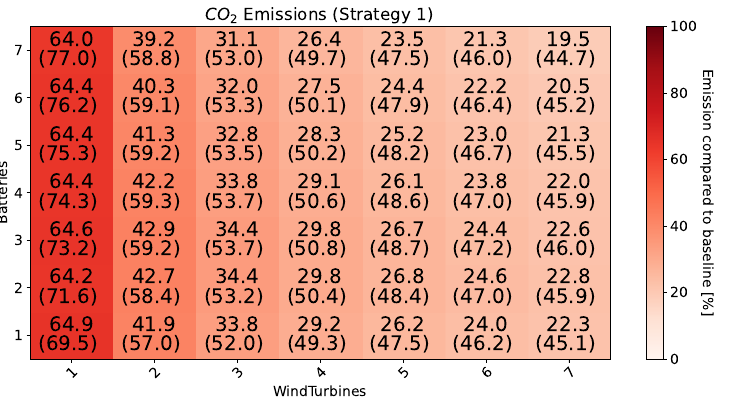
Figure 20. CO 2 emissions relative to baseline when the gas turbines can be turned off completely (0 emissions) or are kept idle with an emission rate of 0.5 kgs − 1 , shown in parentheses.